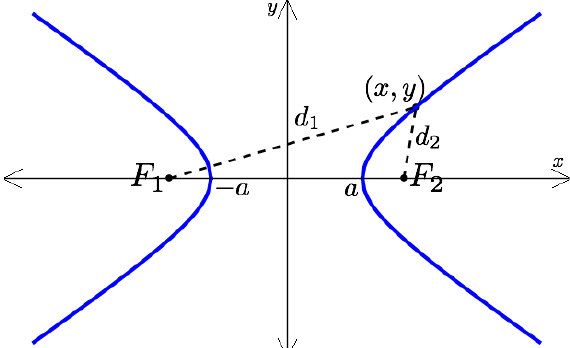
Figure 3. An example of a hyperbola of equation x 2 /a 2 − y 2 /b 2 = 1, with foci at F 1 and F 2 with constant path difference | d 2 − d 1 | = p c 2 − a 2 , where 2 c is the known distance 2 a . b can be generated by between the foci.